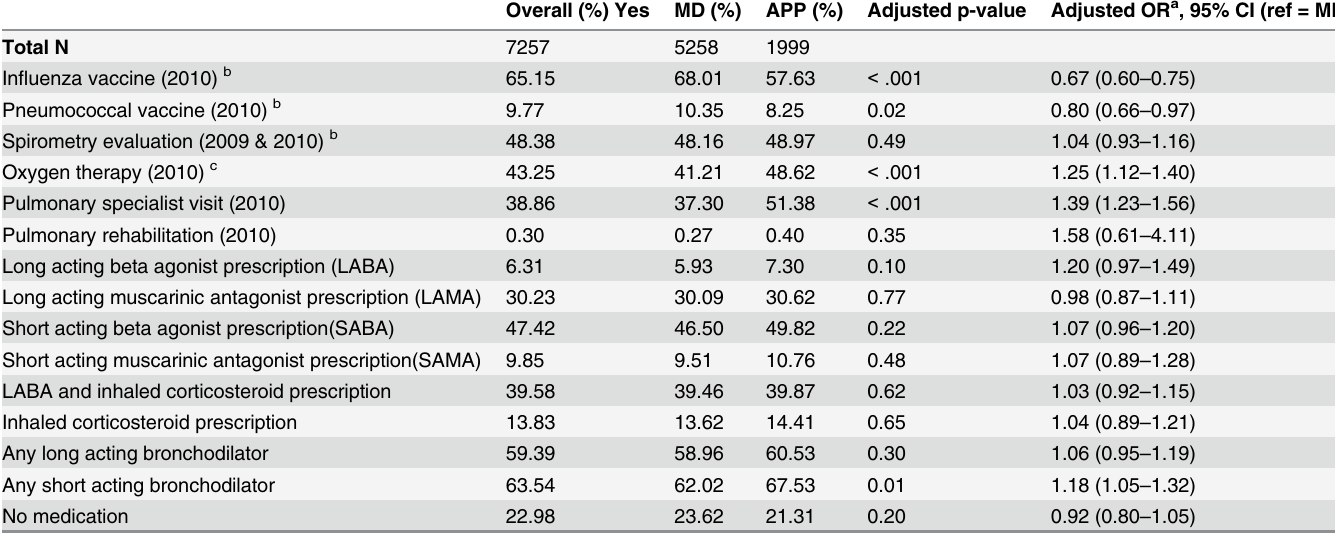
Table 2. Comparison of processes of care measures between MDs and APPs in patients with